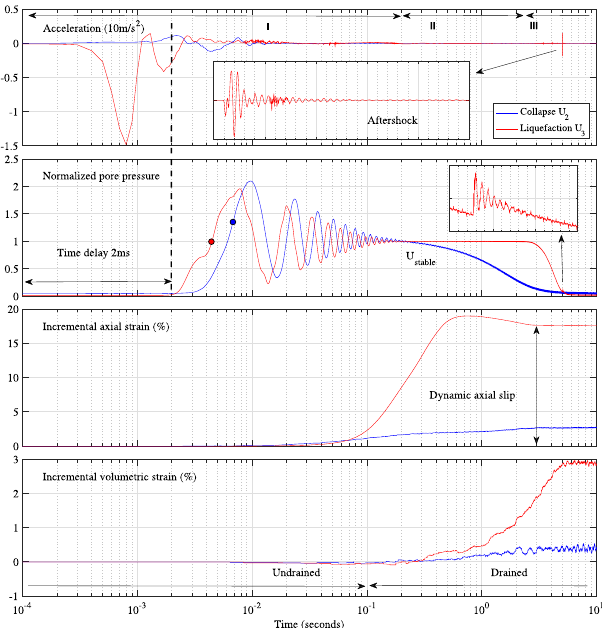
Figure 2. Typical temporal evolution of isotropic collapse U 2 (blue) and liquefaction U 3 (red) on 0.7 mm CVP beads in isotropic drained compression: successively vertical top cap acceleration, normalised excess pore pressure, permanent incremental axial and volumetric strain. The superimposed liquefaction points (solid circles) on normalised excess pore pressure, with systematic time delay (vertical black dashed line), are above the unity level, indicating non-liquefaction event for collapse U 2 . The axial strain of collapse event is magnified by a factor of 30. A small aftershock (inset figures), without affecting the liquefaction results, occurs after 5